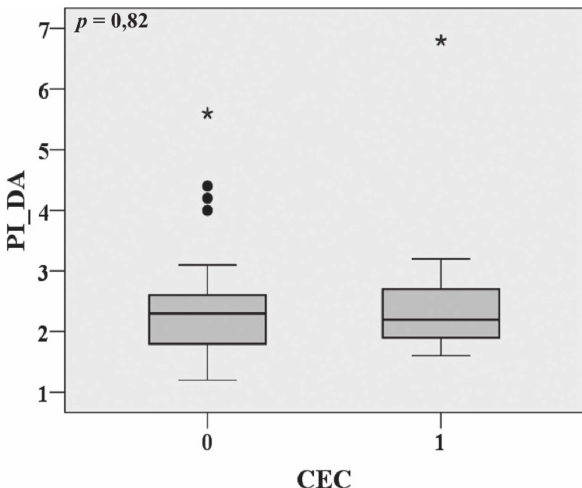
Fig. 4. Comparação do PI da DA entre os grupos RM sem CEC (0) e o grupo RM com CEC (1). PI_DA: índice pulsátil da DA; CEC: circulação extracorpórea; RM: revascularização do miocárdio